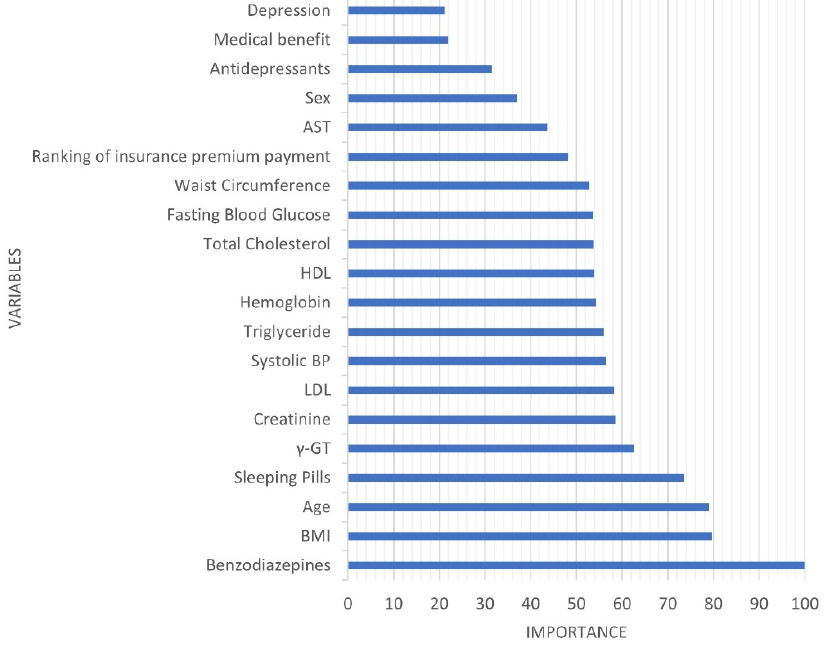
Figure 3. Variables’ importance in the suicide prediction model .